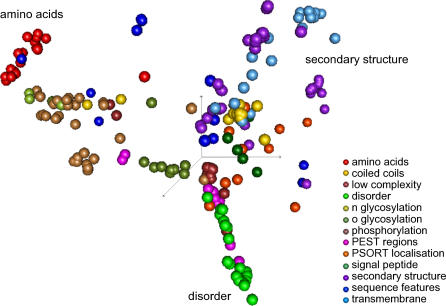
Multidimensional Scaling Plot of Feature Space Represented in Three DimensionsFeature descriptors that are closely correlated across all proteins are close together in feature space. The scale units of the plot are arbitrary and relative to the smallest correlation between feature pairs (1.27e-05) as measured by the Pearson correlation coefficient.